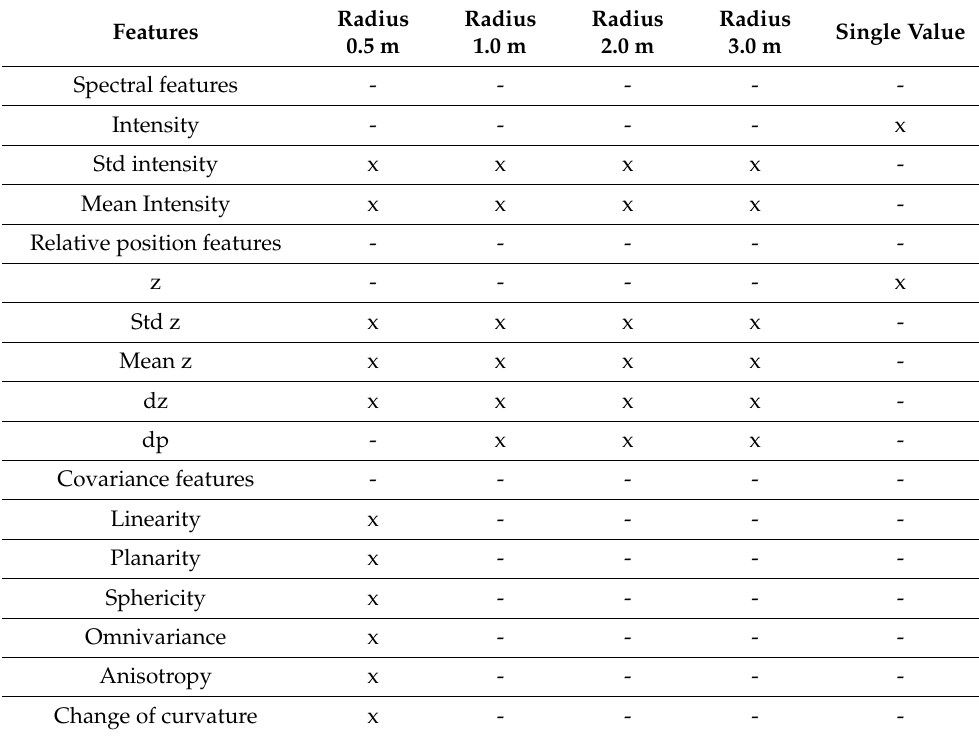
Table 2. Features and neighborhood